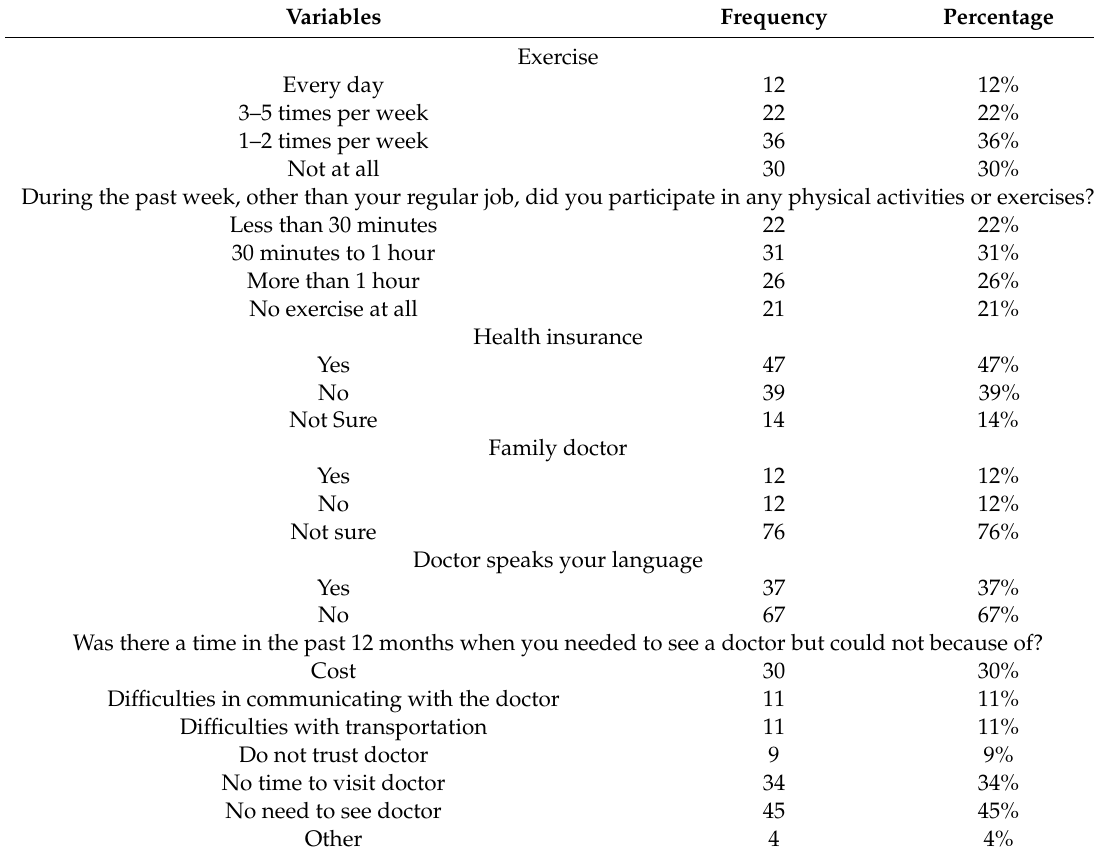
Table 3. Socio-demographic characteristics of study